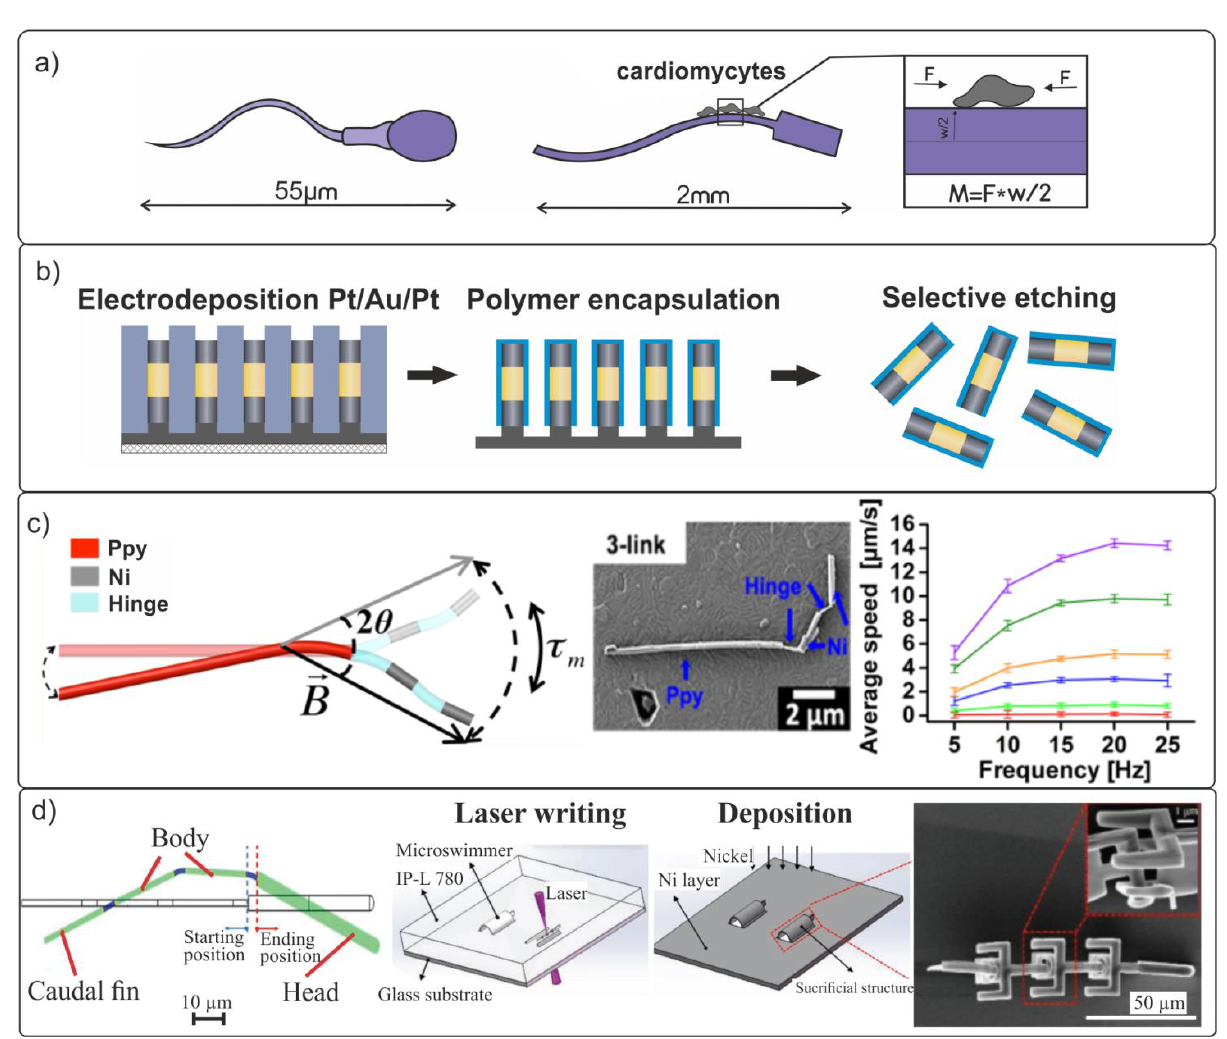
Figure 2. ( a ) Schematic image of biomimetic non-magnetic swimmers. The length of the head and tail of the designed polymer swimmer is ≈400 μm and ≈1500 μ m, respectively. The self-propulsion speed reaches ≈10 μ m/s. ( b ) The concept of manufacturing magnetic nanorods with a flexible polymer hinge. The image shows the flexible part of the polyelectrolyte shell connecting two Ni/Au/Pt segments. ( c ) Schematic and SEM image of 3-link swimmers [76]. Copyright 2012, American Chemical Society. The graph shows the dependence of the average propulsion speed on the frequency for 3-link swimmers. ( d ) Three-dimensional laser lithography and deposition of a Ni layer for magnetic actuation. The microswimmer made in IP-L 780 polymer using 3D laser lithography and the deposition of a Ni layer for magnetic actuation [77]. The total length of the microswimmer is 120 μ m and the length of its magnetic head is ~40 μ m.